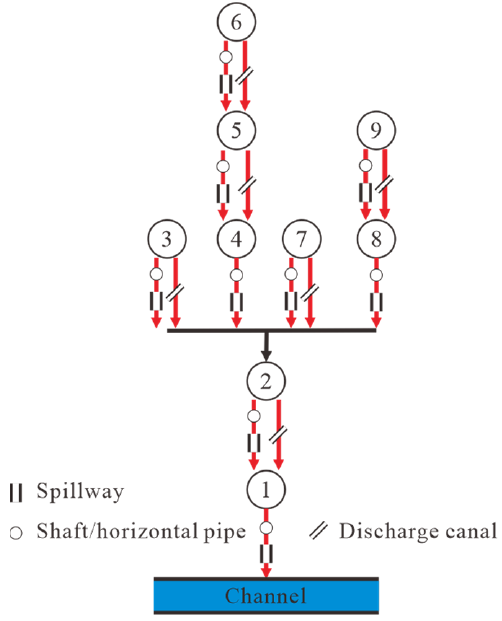
Figure 8. Optimal connection mode in a dam system (the shaft, horizontal pipe and spillway can be in separate or combined forms).